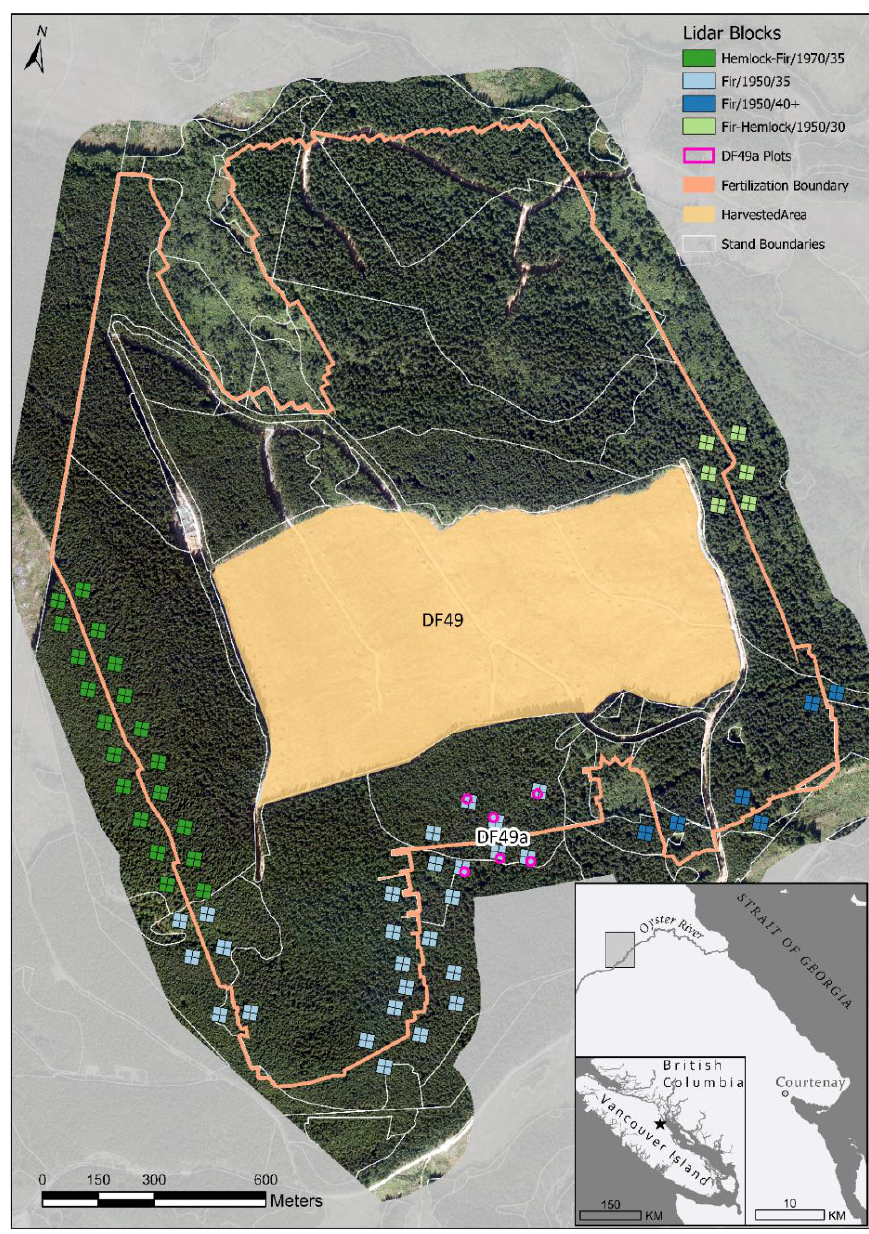
Figure 1. Study area map showing the fertilization area (orange lines); DF49a fertilized and control sample plots (pink); and LiDAR blocks for forest stand analysis units of Hemlock-Fir (dark green), Fir (Site Index 30) (light blue); Fir (Sight Index 40+) (dark blue); and Fir-Hemlock (light green). The main stand, DF49, was the location of flux towers and plots established in 2002 and measured until 2011, when the stand was cut. White lines show the 2010 forest stand polygon